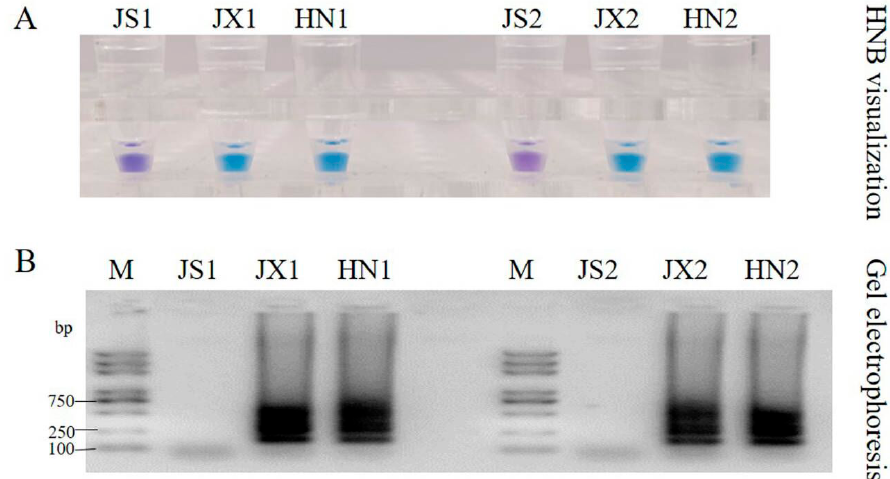
Figure 8. Detection of field strain of C. suppressalis from different regions by the LAMP technique. M. Trans 2K Plus DNA marker.